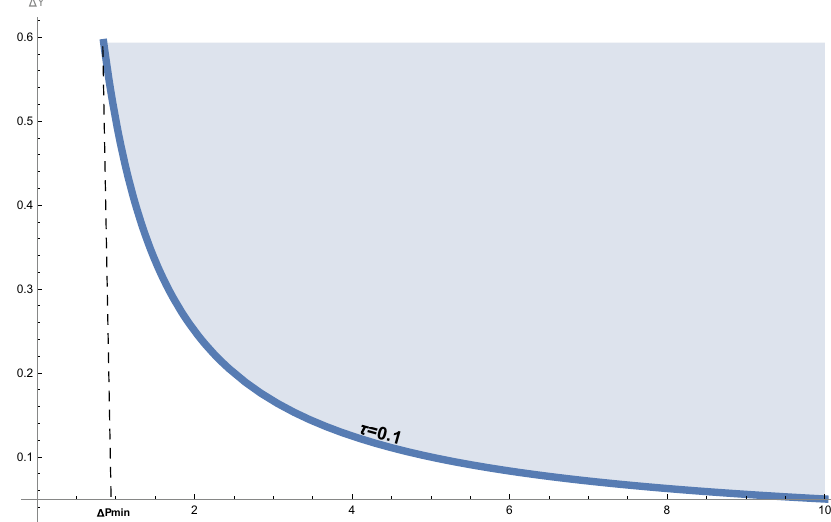
Figure 4. Generalized Heisenberg uncertainty (19) in accordance with ordinary Heisenberg uncertaity (21) after rescaling to dimensionless form. The blue shade region represents states allowed by both quantum gravity and quantum mechanics. This result is consistent with that of Perivolaropoulos 11 .